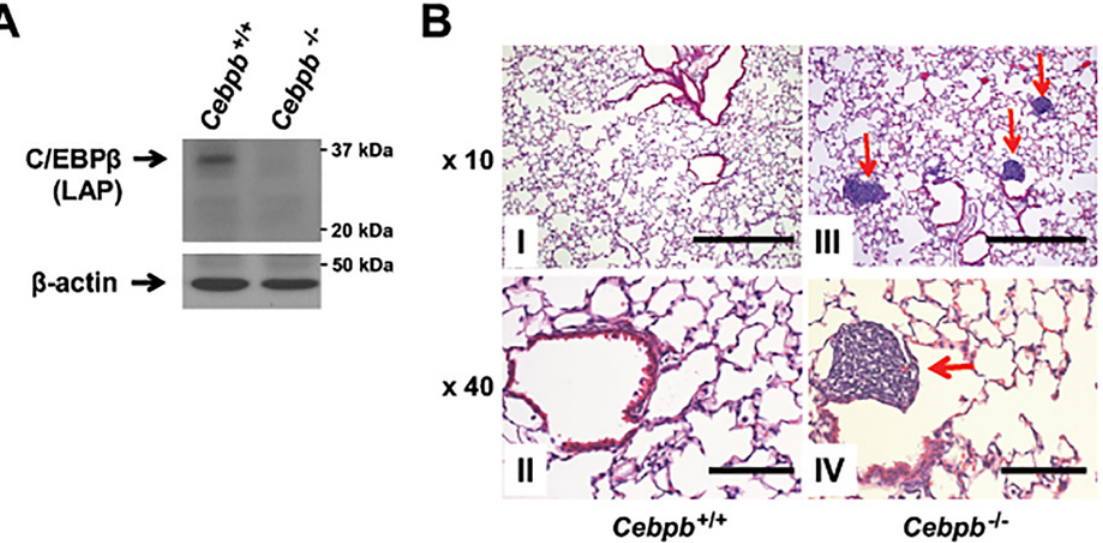
Fig 2. Deletion of Cebpb has no effect on lung structure, but leads to aggregation of lymphoid cells in the lung. (A) Immunoblots of lung extracts from Cebpb +/+ or Cebpb -/- mice. Note that the predominant isoform expressed in mouse lungs is LAP and C/EBP β expression in the lung is effectively lost in Cebpb -/- mice. (B) Representative images of hematoxylin and eosin staining of lungs isolated from Cebpb +/+ (I and II) and Cebpb -/- (III and IV) mice. We analyzed 10 Cebpb +/+ and 8 Cebpb -/- mice. Scale bars = 500 μ m (I and III) and 100 μ m (II and IV). Arrows indicate scattered lymphocyte aggregates in the lung parenchyma of a Cebpb -/- mouse. No gross or histologic architectural abnormalities were observed in the lungs of Cebpb -/-